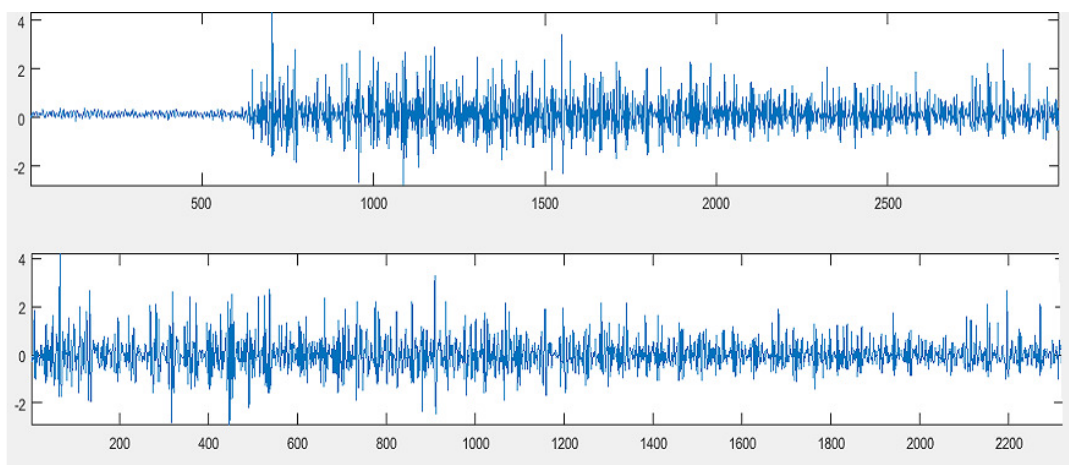
Figure 1. On top, the original signal; on the bottom, the clipped signal with a zero mean